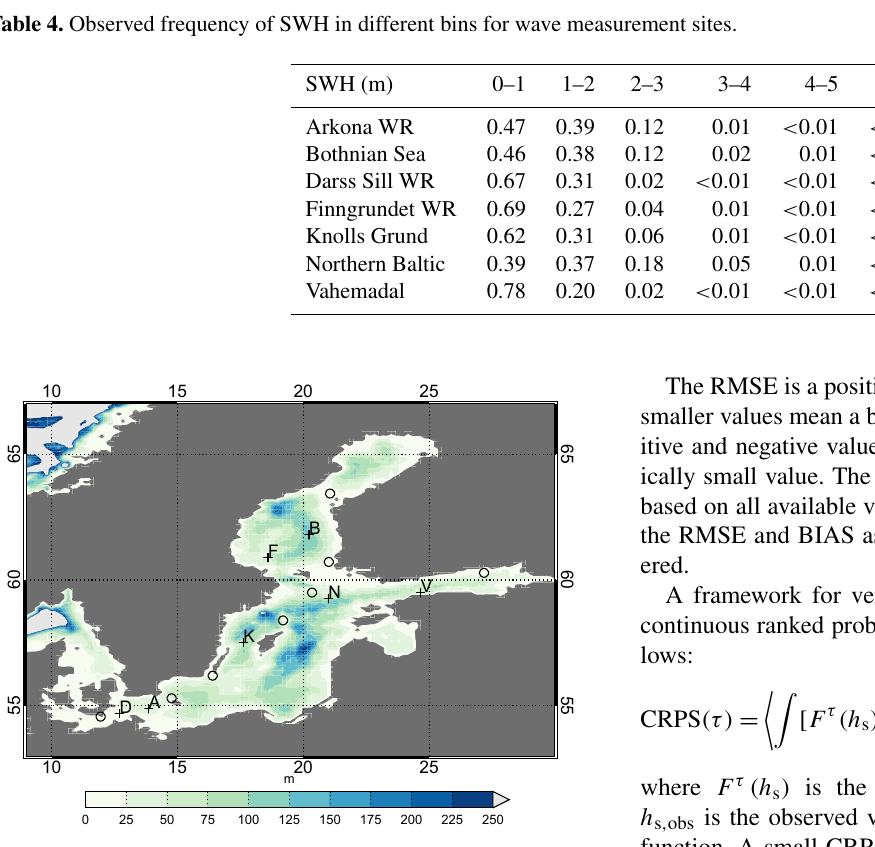
Figure 3. Map of the Baltic Sea with bathymetry and the positions of wave measurement sites marked with crosses. For details about the sites see Table 3. Meteorological stations used in the wind veri- fication of DMI-HIRLAM are marked with